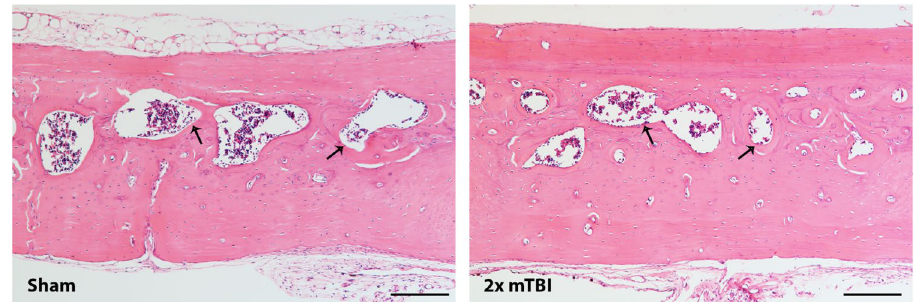
Figure 4. Hematoxylin and eosin staining of representative interparietal skull bone samples from sham and 2 × mTBI rats, at 10 weeks post-injury. A larger volume of trabecular bone is evident in the 2 × mTBI sample compared to sham, alongside a reduction in the volume of marrow cavities (arrows). Scale bar = 200 µm.